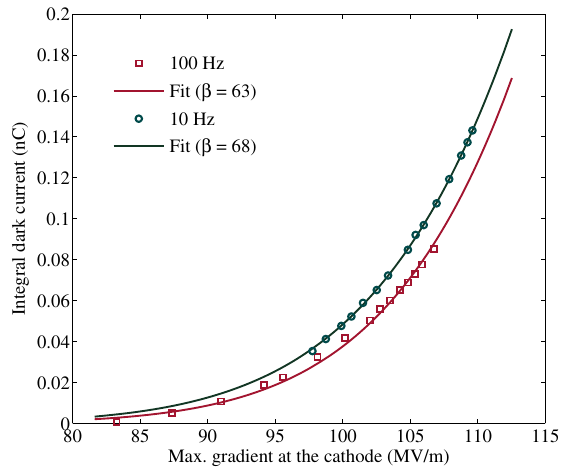
FIG. 19. Integrated dark current per rf pulse as a function of the peak electric field at the cathode at 10 Hz and 100 Hz repetition rate (SwissFEL gun).